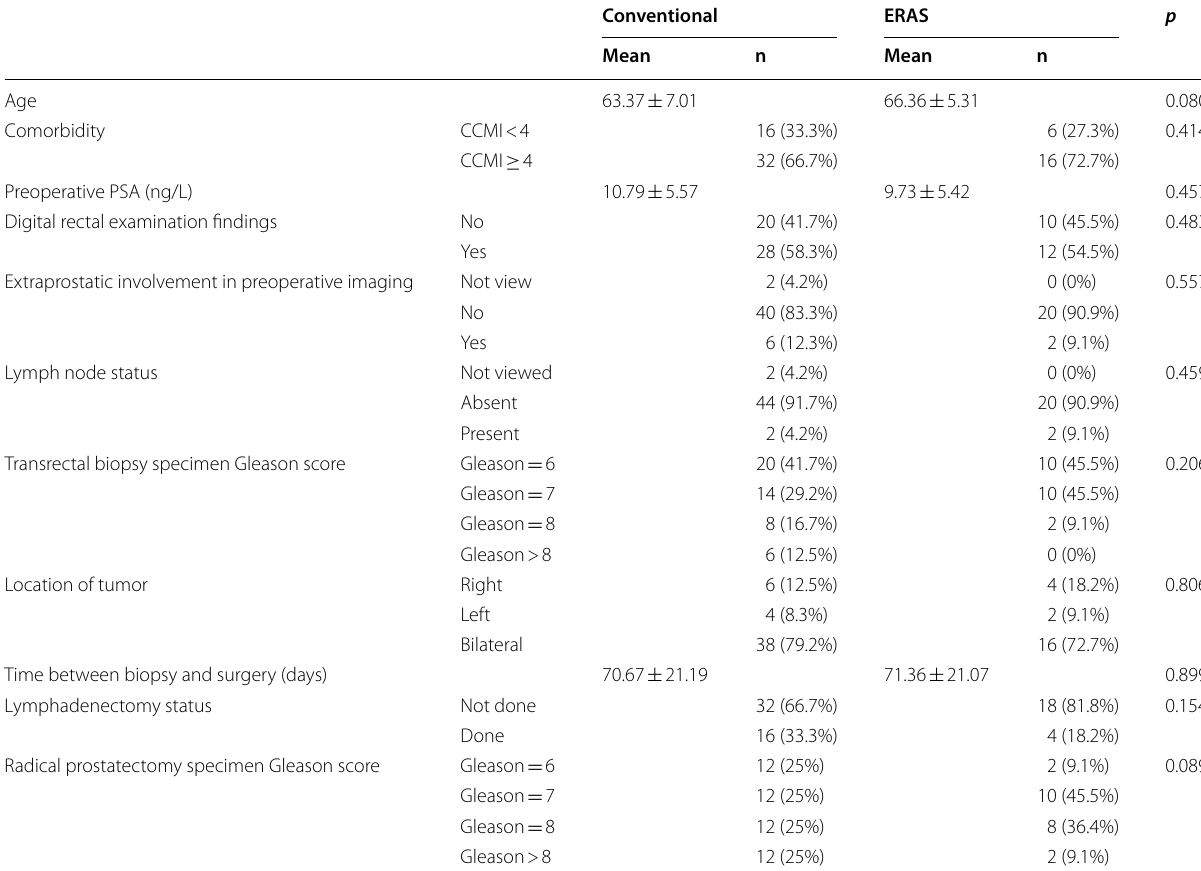
Table 1 Demographic and clinical characteristics of the patients